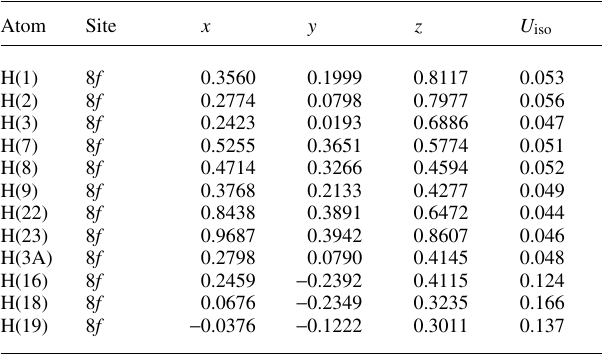
Table 2. Atomic coordinates and displacement parameters (in Å 2 )